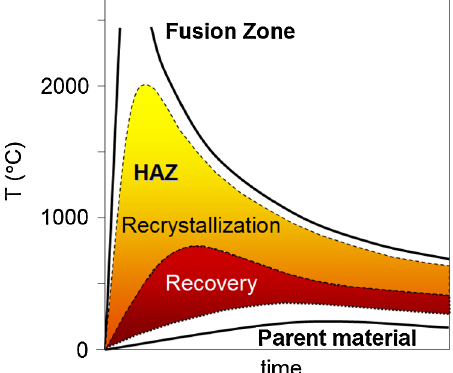
FIG. 17. (Color) Schematic diagram of heating and cooling history in different zones of a weld [41].